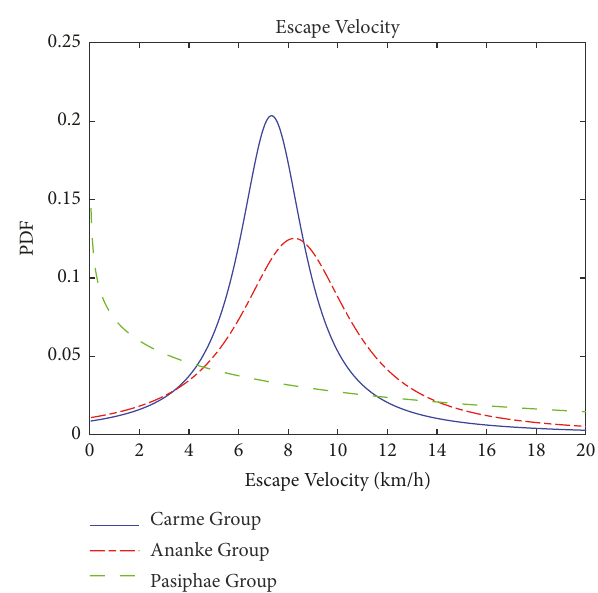
Figure 8: The PDF curves of escape velocity. and (8.21989, 0.0112805), respectively. So the corresponding predicted PDFs can be written as